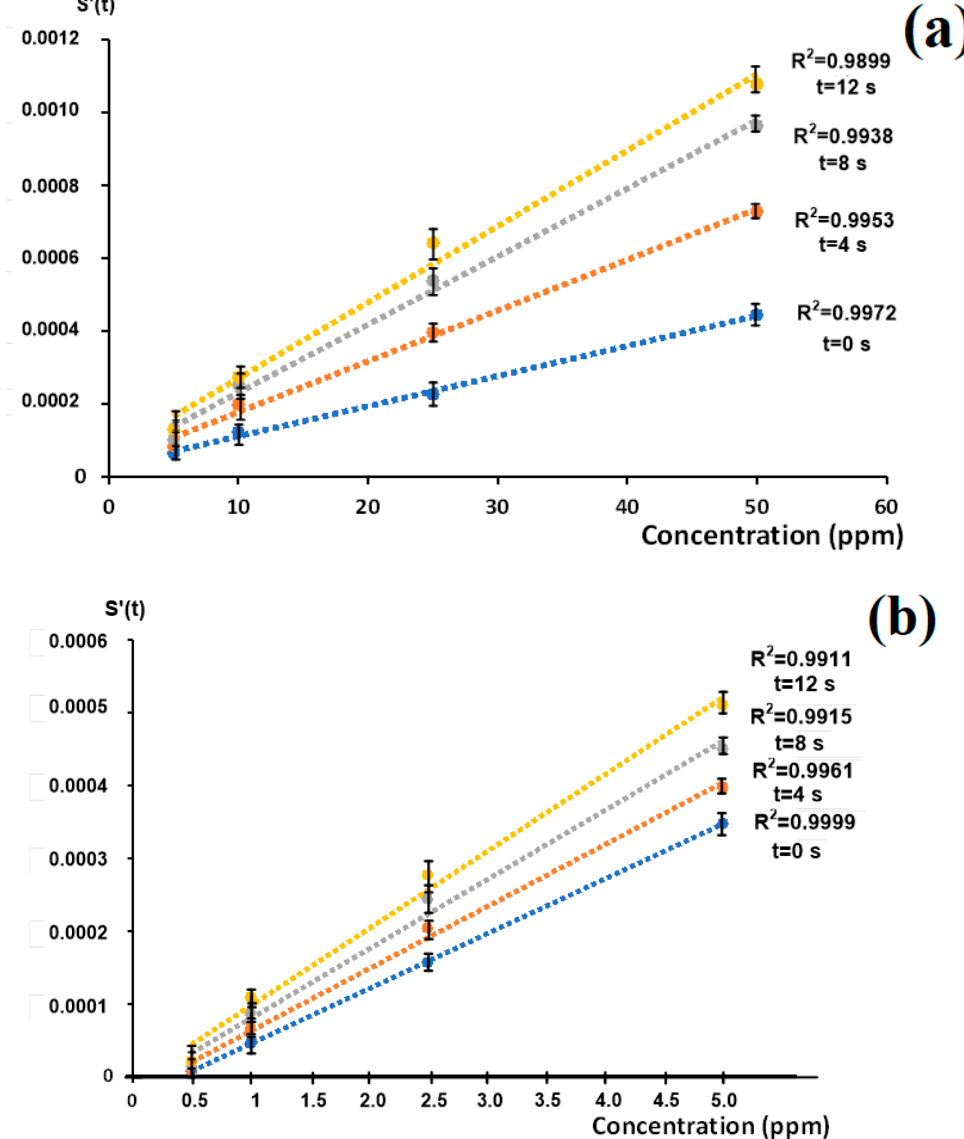
Figure 8. Calibration curves S ′ ( t ) at different moments: ( a ) Type 1 sensor; ( b ) Type 2 sensor.